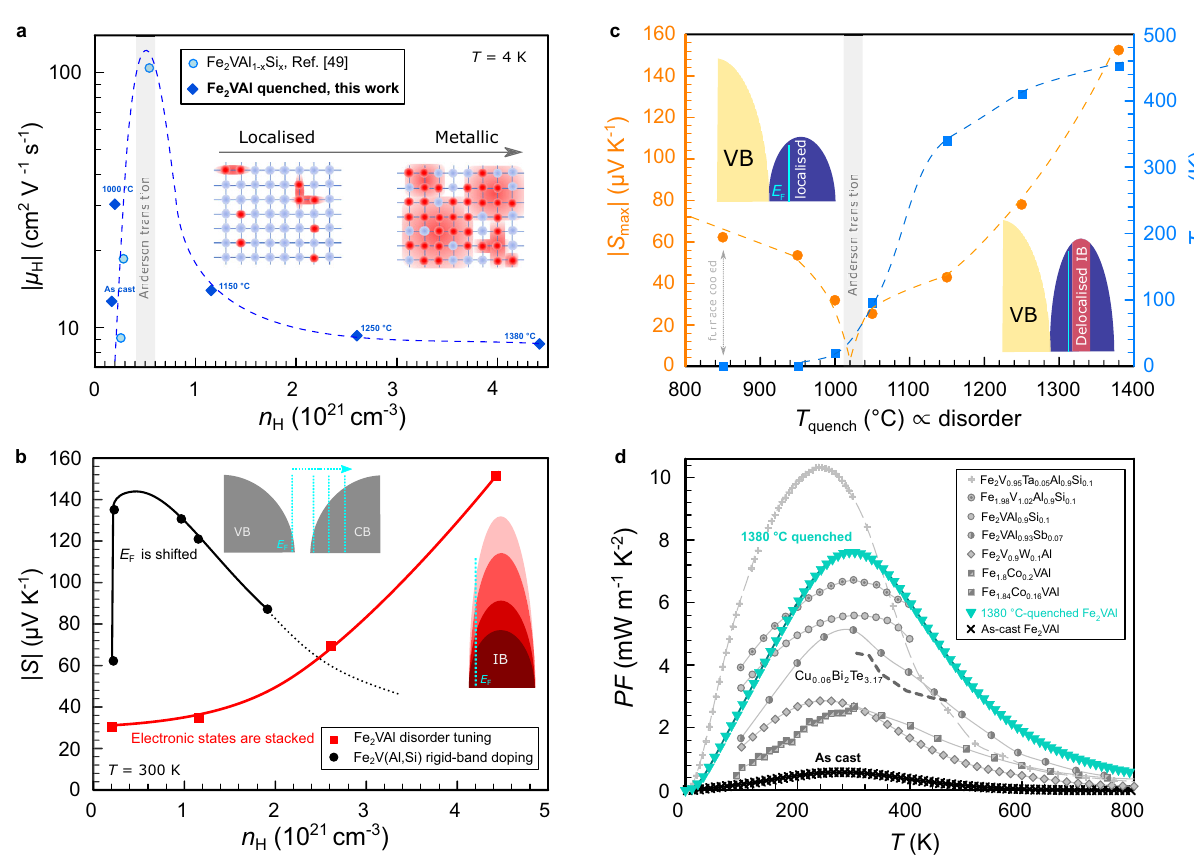
Fig. 5 Delocalisation of impurity band and high thermoelectric performance driven by antisite disorder. a Hall mobility versus carrier concentration at T = 4 K. b Thermopower versus carrier concentration (Pisarenko plot) for disorder-tuned Fe 2 VAl and conventionally doped Fe 2 VAl 1 − x Si x . c Peak values of the thermopower and temperature of the maximum of the resistivity versus quenching temperature. Dashed and solid lines are guides to the eye. d Power factor of as-cast and 1380 ∘ C-quenched stoichiometric Fe 2 VAl compared to the optimum power factors obtained by extrinsic n -type doping on the Al, V and Fe sites (Fe 2 VAl 1 − x Si x 45 , Fe 2 VAl 1 − x Sb x 46 , Fe 2 V 1 − x W x Al 47 , (Fe 1 − x Co x ) 2 VAl 48, 49 ) as well as co-doping Fe 2 V 0.95 Ta 0.05 Al 0.9 Si 0.1 50 and off-stoichiometry Fe 1.98 V 1.02 Al 0.9 Si 0.1 51 . For comparison, the highest n-type power factor reported for the state-of-the-art thermoelectric Bi 2 Te 3 -system 52 is plotted as dashed